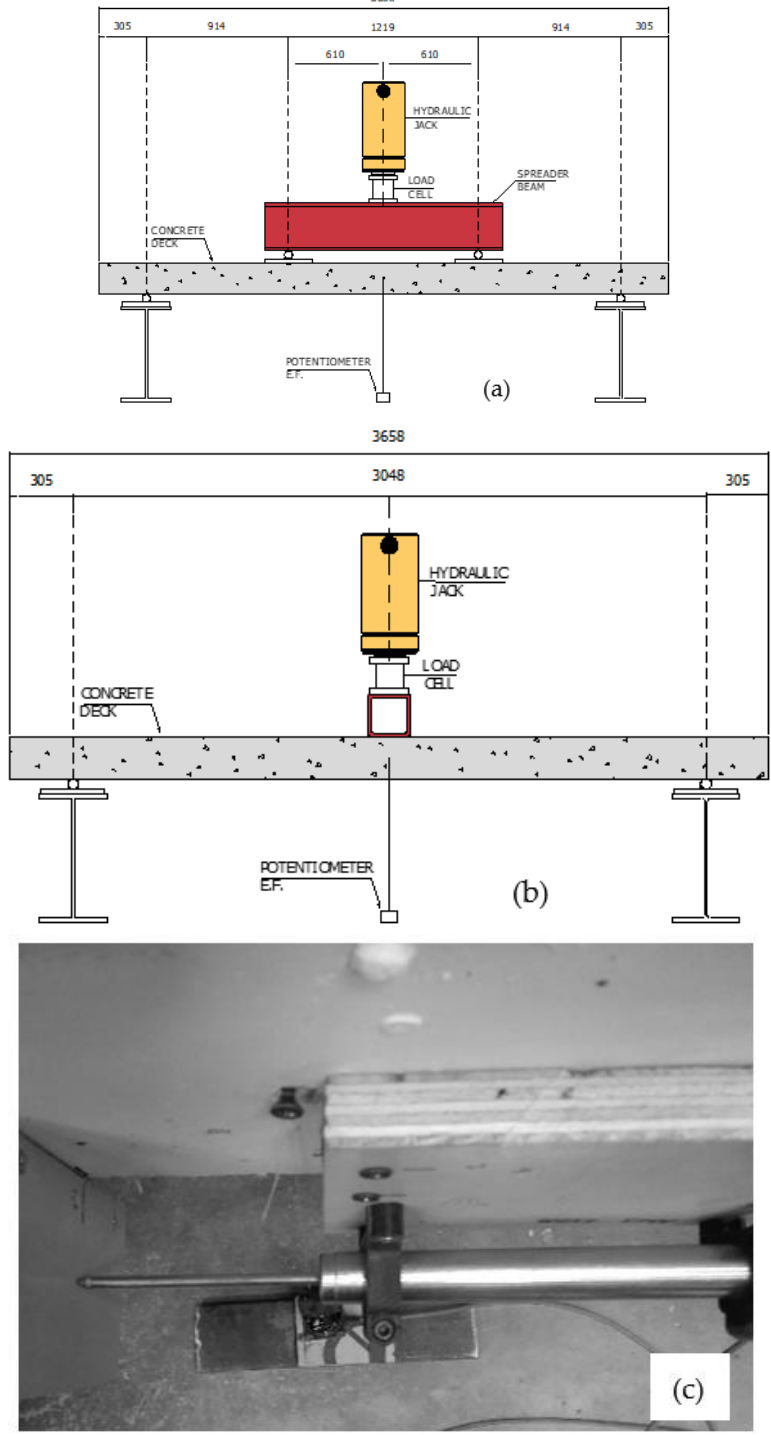
Figure 4. Test setup and instrumentation ( a ) 4-point load, ( b ) 3-point load, and ( c ) LVDT sensor installed at the location of the dominant crack opening.